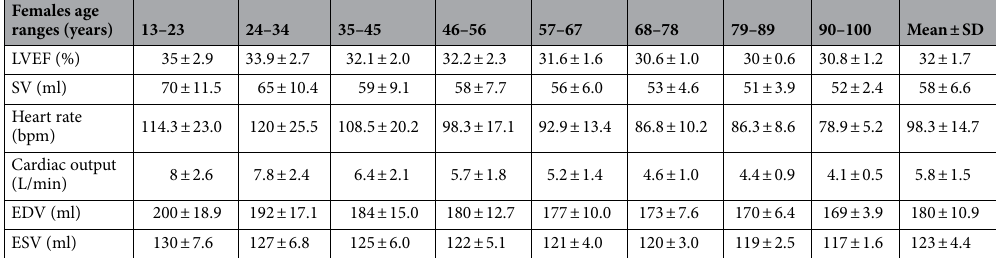
Table 7. LV volumes and systolic function by age decile in IHD female patients using CMRI. Left ventricle ejection fraction LVEF , Stroke volume SV , End diastolic volume EDV , End systolic volume ESV.